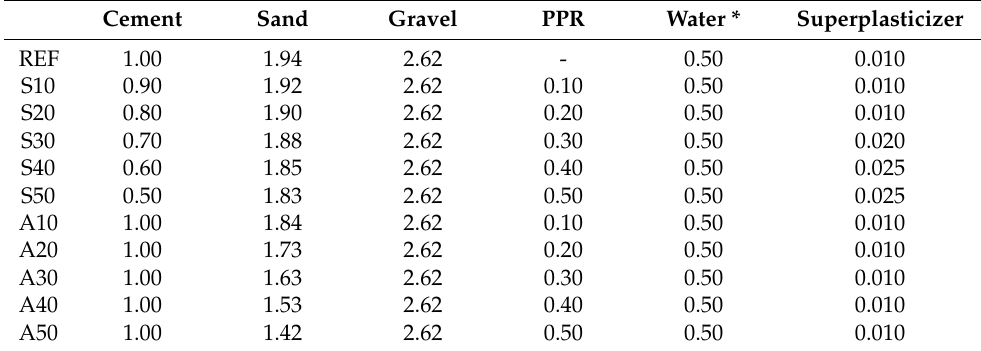
Table 3. Concrete mixes